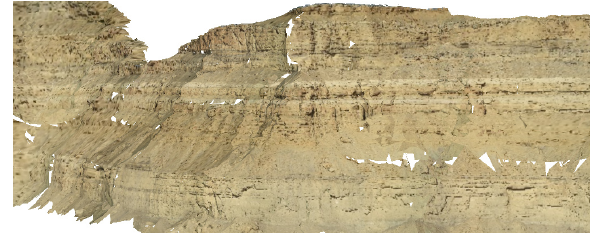
Figure 5. A photorealistic 3D model of a geological outcrop. Model textured using images selected by the automatic OQ algorithm with 3% of allowable untextured